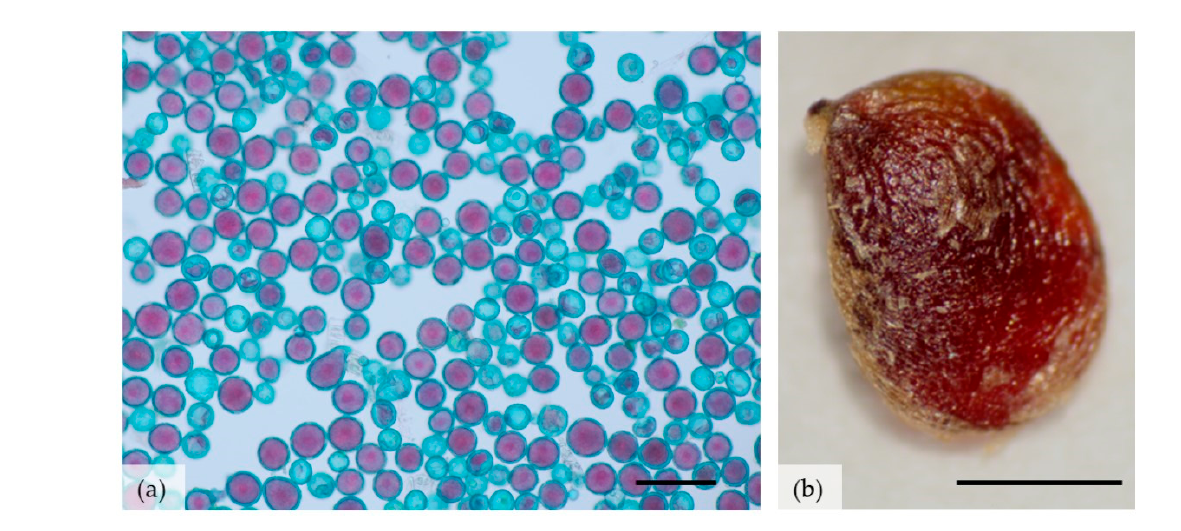
Figure 6. Viability of pollen and seeds of Ranunculus illyricus , ( a ) pollen after Alexander staining: red pollen grains are viable; ( b ) seed after tetrazolium staining—living tissue is red. Scale bars: ( a ) 100 μ m, ( b ) 1 mm. Table 6. The effect of hot stratification and temperature on germination ability of Ranunculus illyricus Table 5. The production and viability of pollen and efficiency of fruit setting of Ranunculus illyricus . seeds [% per plate ±